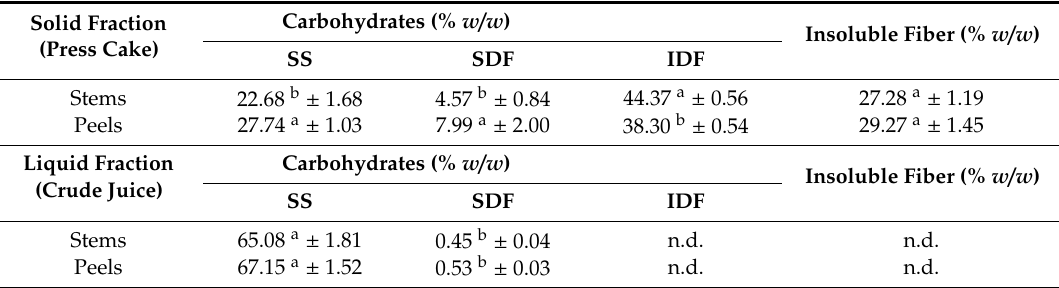
Table 2. Total carbohydrate (average ± standard deviation) composition of pineapple by-products liquid and a solid fraction (peels and stems) in dry